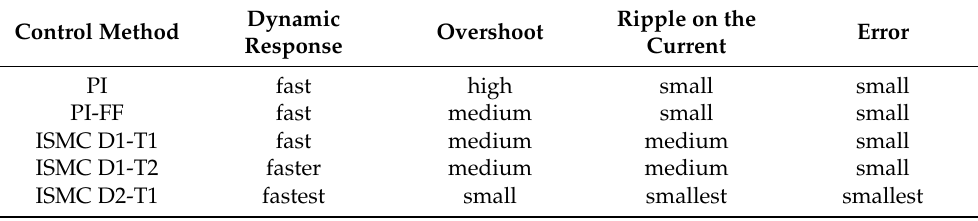
Table 3. Comparison of the proposed method vs two other existing methods.